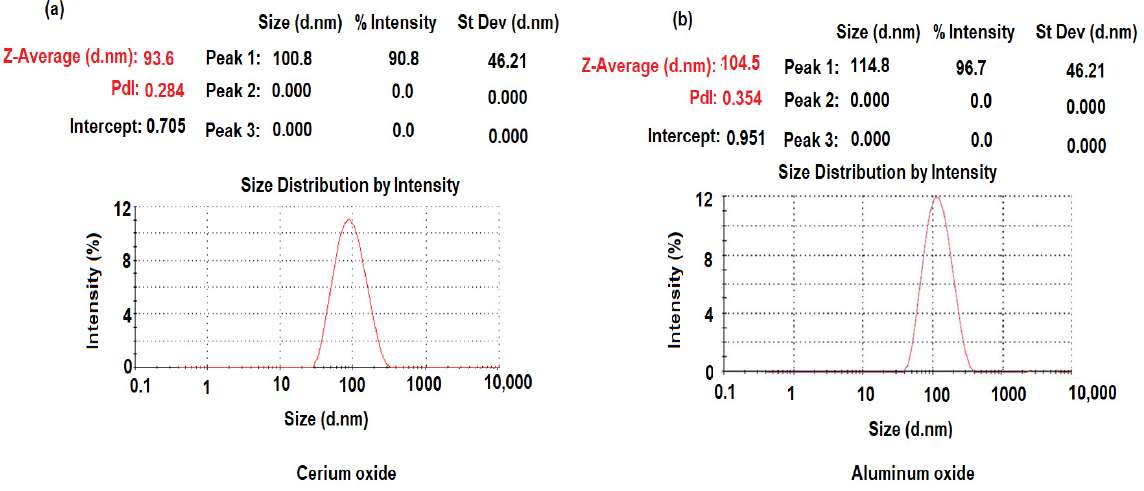
Figure 7. Dynamic light scattering of pre-synthesized ( a ) CeO 2 NPs and ( b ) Al 2 O 3 NPs. The size distribution profiles of CeO 2 NPs and Al 2 O 3 NPs exhibited one remarkable peak for each with intensities 90.8%, 96.7%, respectively, with a polydispersity index (PdI) 0.284 and 0.354 for CeO 2 NPs and Al 2 O 3 NPs, respectively, suggesting that the synthesized nano metal oxides had a little agglomeration [61]. The zeta potential of pre-synthesized CeO 2 NPs and Al 2 O 3 NPs with negative values of about − 25.5 and − 17.6 mV indicated a strong negative charge (Figure 8a,b). The negative surface zeta potential of CeO 2 NPs and Al 2 O 3 NPs suggests their reduction in metal oxide nanoparticles.